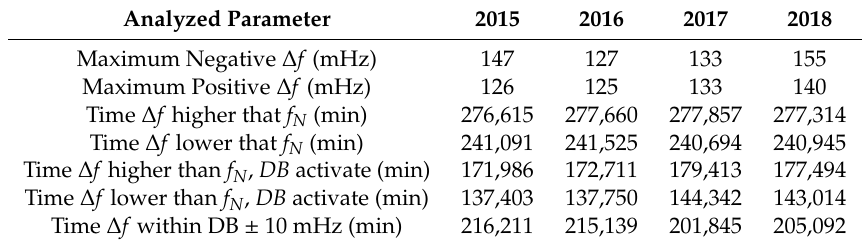
Figure 6. ( a ) Probability density function of the grid frequency data in 2018. ( b ) Cumulative distribution function of the grid frequency data in 2018. Table 2. Numerical outputs of the historical frequency data analysis. ∆ f : frequency deviation and f N : nominal frequency